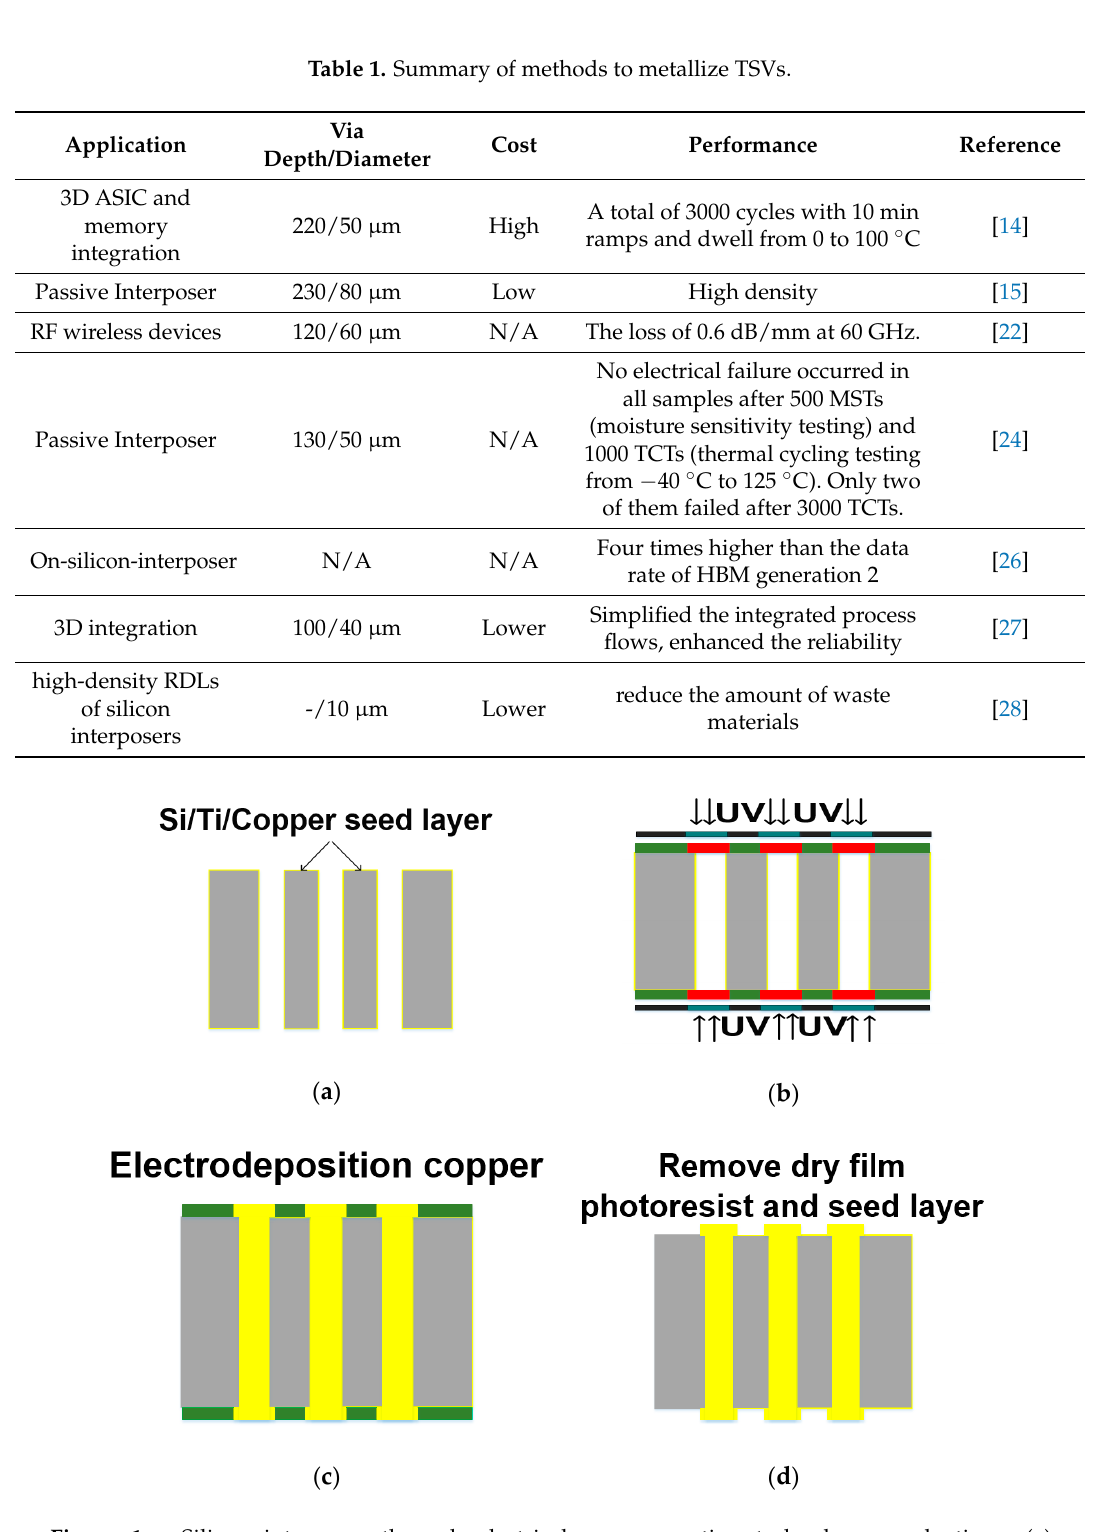
Table 1. Summary of methods to metallize TSVs.